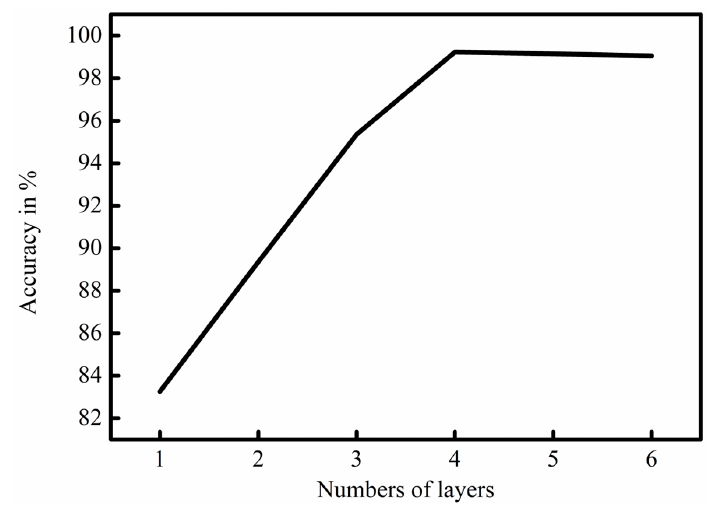
Figure 6. The accuracy of the impact of numbers of layers